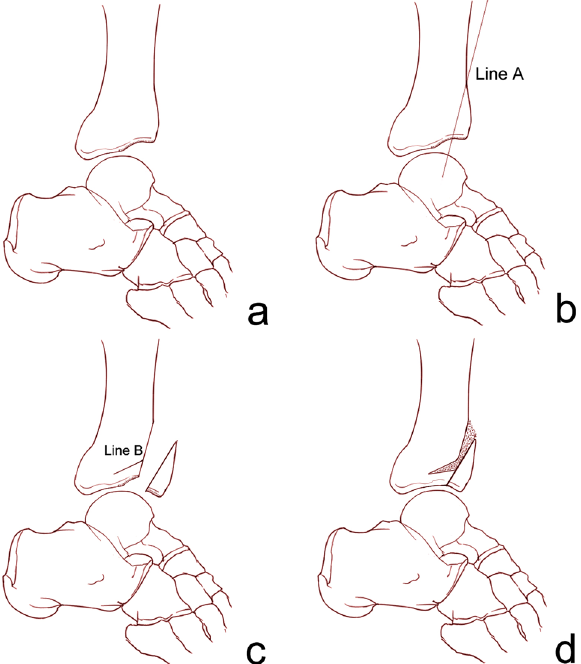
Figure 4. Schematic drawing of anterior distal tibial plafond-plasty. ( a ) Impaction of the anterior distal tibial plafond was noticed after the talus was reduced back to its normal position. ( b ) An anterior distal tibial osteotomy was performed along line A, from the superior anterior distal tibia to the apex of the impacted area. ( c ) A second osteotomy (line B) was performed just above the subchondral bone of the impacted articular surface. The articular surface step-off was reduced. ( d ) The distal tibial fragment was slid distally until a congruent ankle joint was